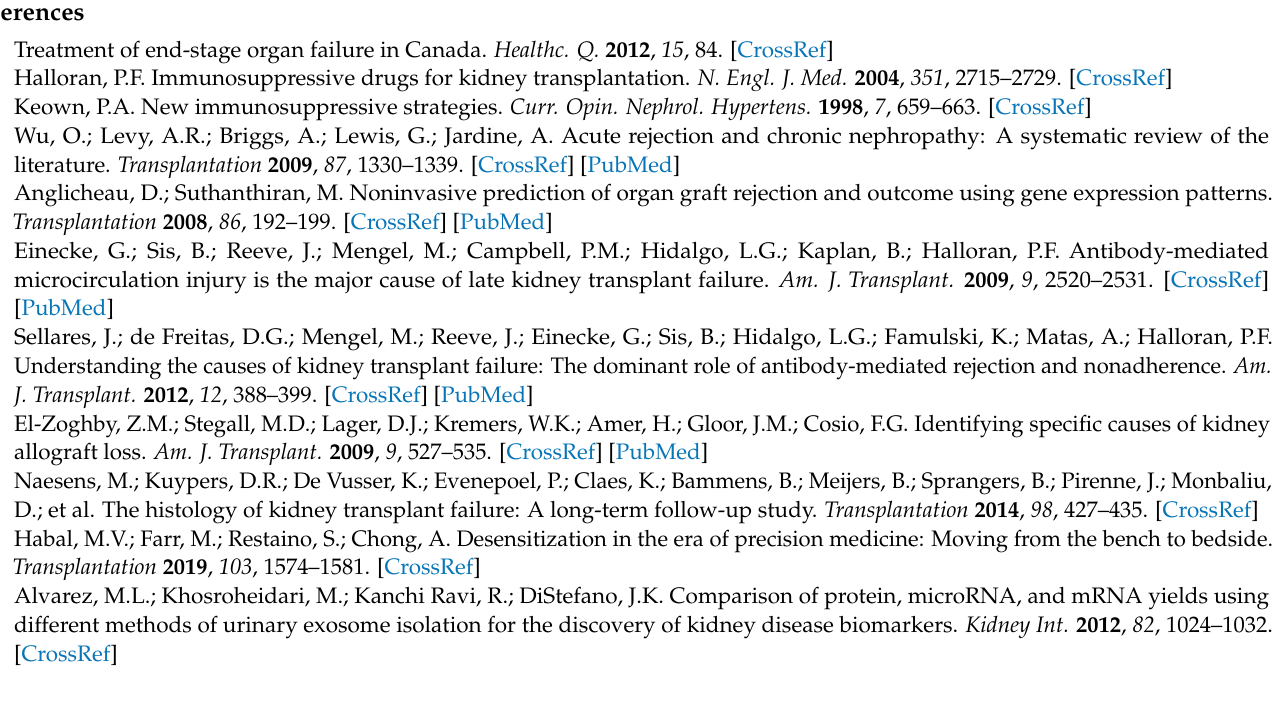
Table S4: List of antibodies used for Western blot analysis and